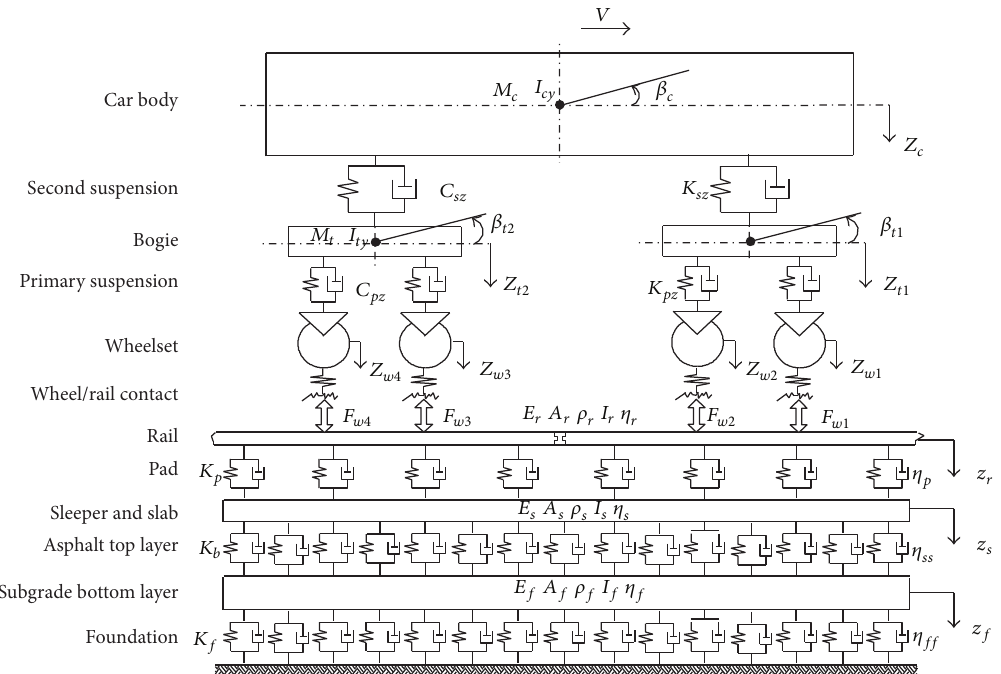
Figure 1: Model of vehicle-double block ballastless track-subgrade coupled